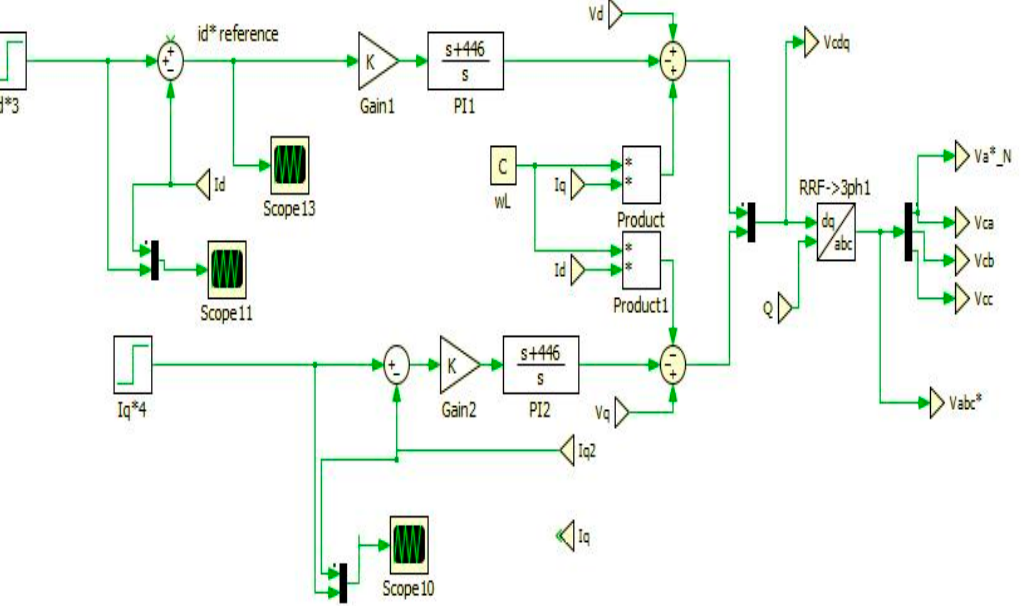
Figure 20. The dq transformation technique for the fractional converter.